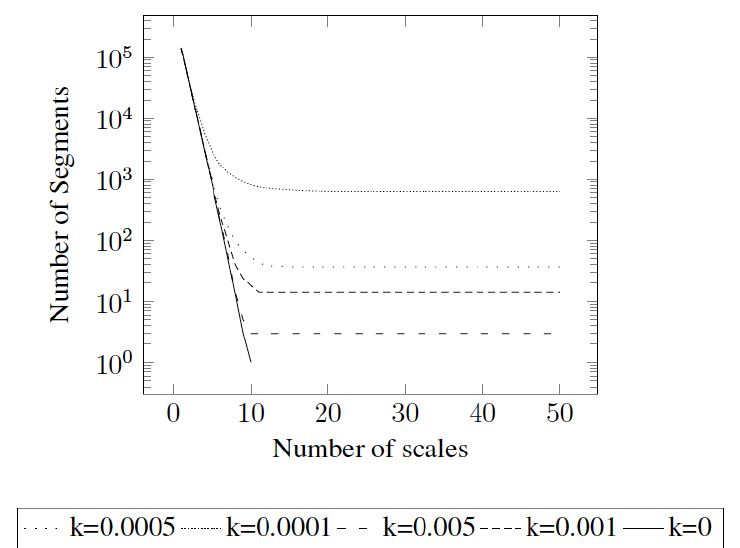
Figure 4. Dependency of the aggregation process on parameter k . The lower k , the lower the constraints to aggregate segments. Notice that k = 0 means no stopping condition.